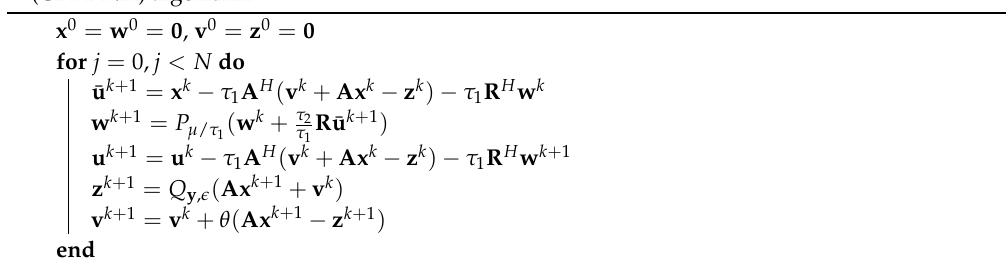
Algorithm 3: The pseudocode for the generic generalized basis pursuit denoising algorithm (GBPDNA) algorithm